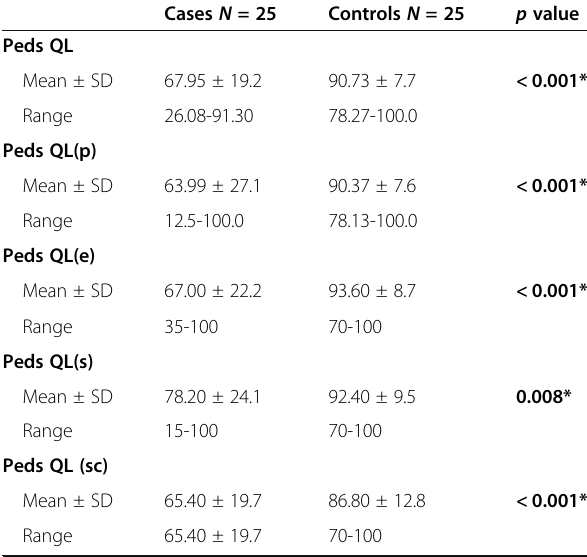
Table 2 Pediatric quality of life inventory 4.0 generic core scales (PedsQL) among studied population ( N = 50)